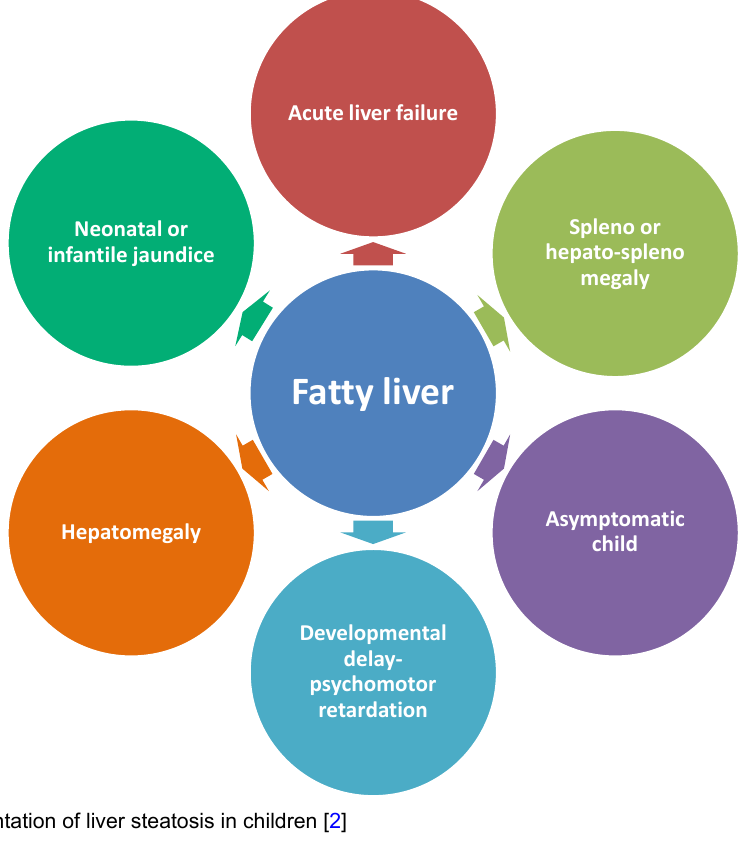
Figure 1. Clinical presentation of liver steatosis in children